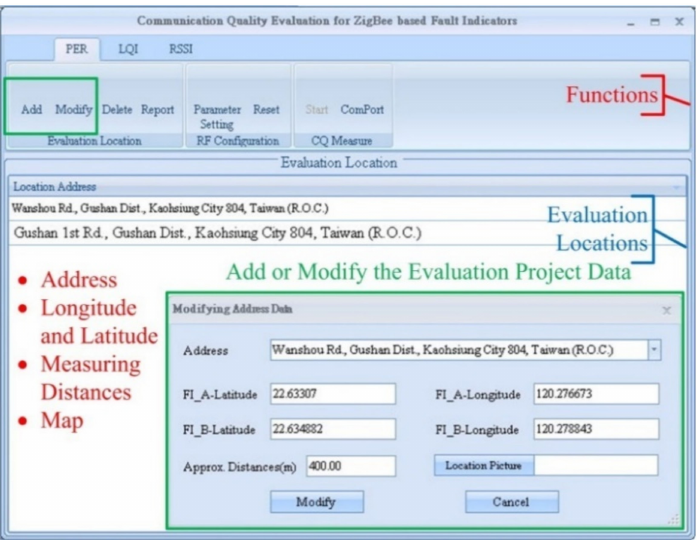
Figure 5. Human–Machine Interface (HMI) of the proposed communication evaluation